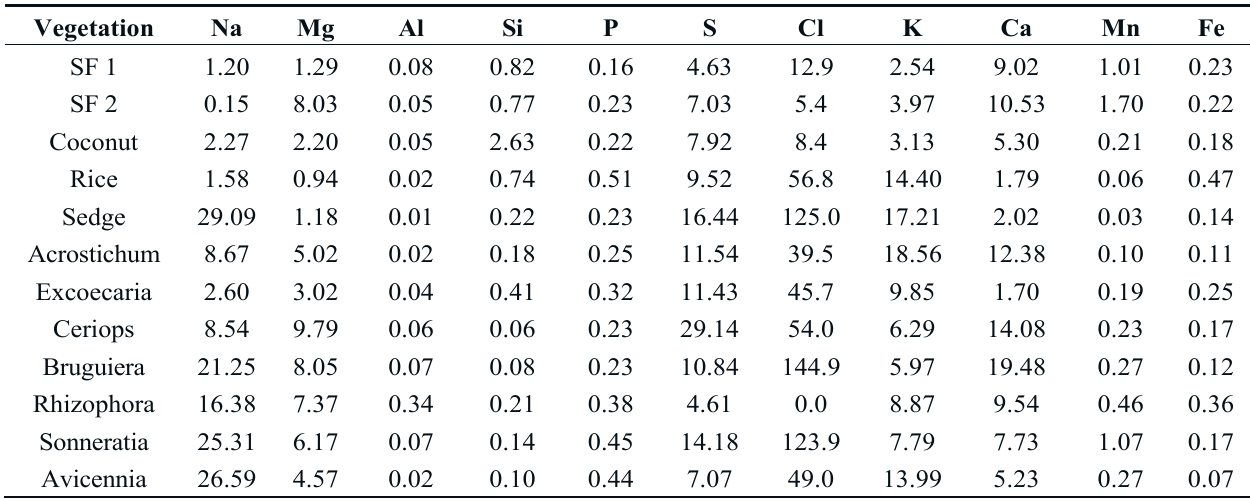
Table 6. Macro and micro element concentrations (g/kg) determined by leaf analysis.